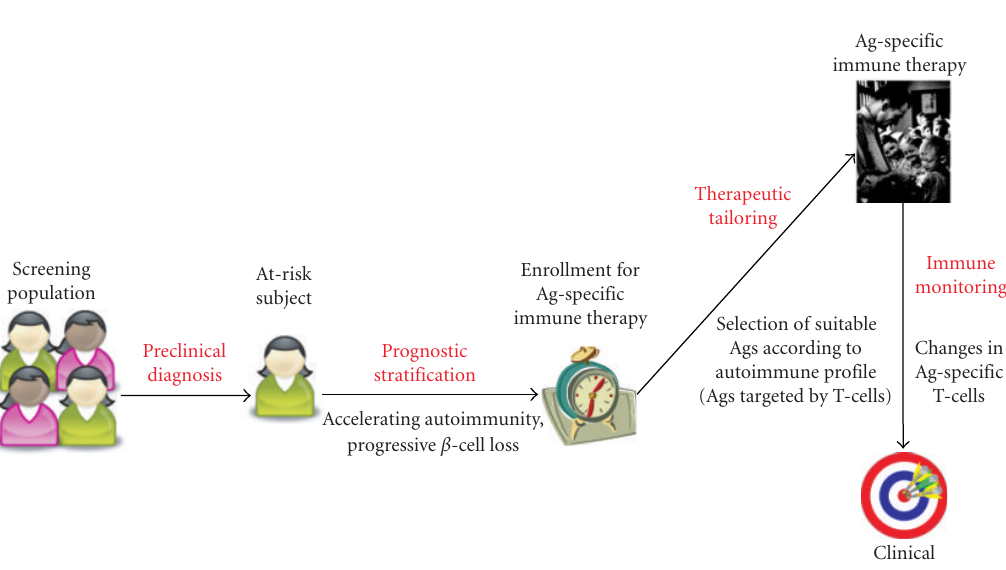
Figure 3: “Immune staging” of T1D. Biomarkers of β -cell autoimmunity such as aAbs and T cells could help to identify at-risk subjects at an early stage (preclinical diagnosis) and to follow them up over time to decide the need for immune therapy and the best timing for treatment (prognostic stratification). Ag-specific immune therapy could be personalized for each subject by administering therapeutic formulations of those Ags targeted by aAb and/or T-cell responses. Modifications induced on such responses could be followed in real time during treatment, thus allowing to assess immune e ffi cacy prior to and independent of clinical